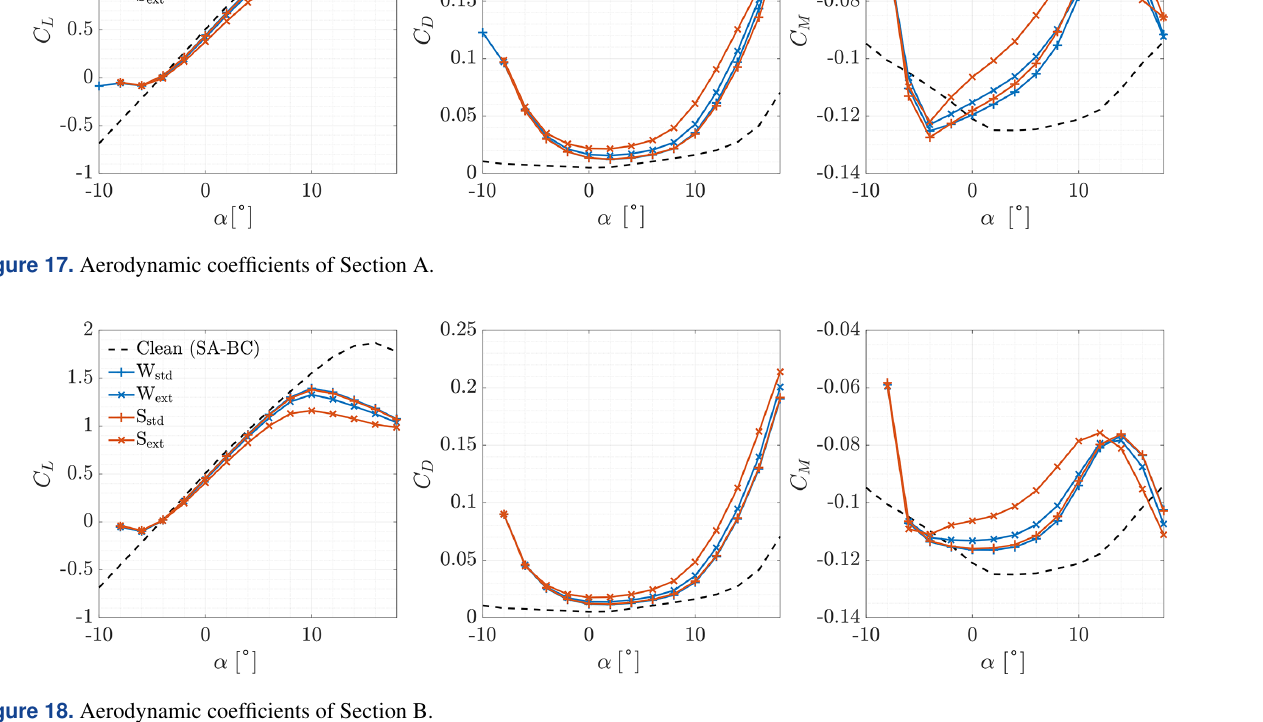
Figure 18. Aerodynamic coefficients of Section B.